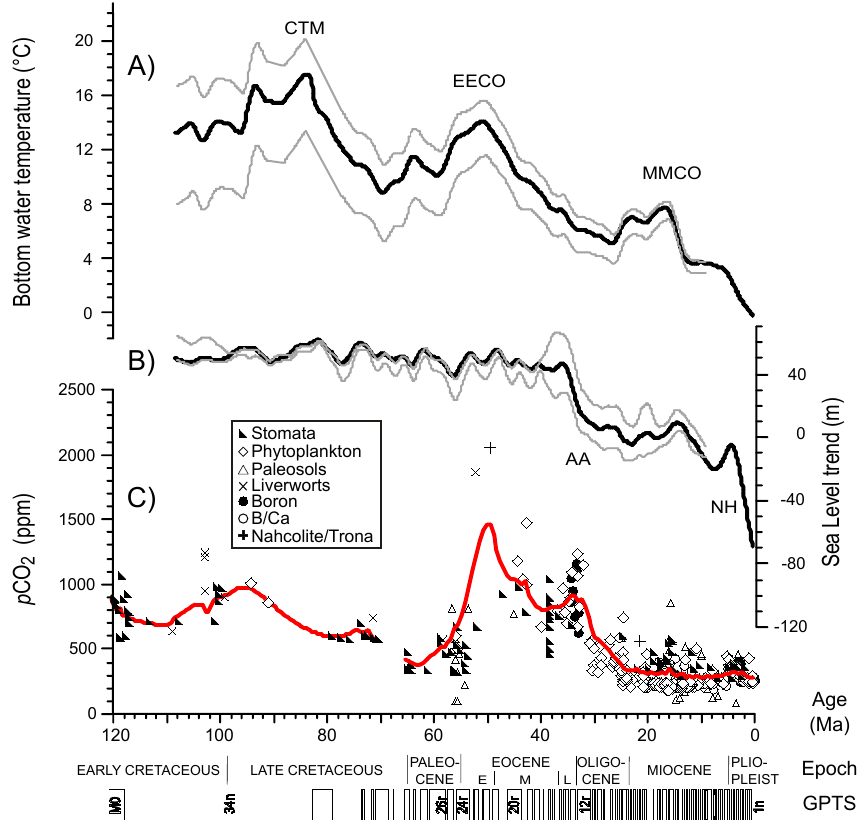
Fig. 1. Bottom water temperatures (A) and reconstructed sea levels (B) since the Early Cretaceous (Cramer et al., 2011) smoothed to emphasize variations on > 5Myr timescales. CTM is Cretaceous thermal maximum, EECO is early Eocene climatic optimum, and MMCO is middle Miocene climatic optimum; AA is sea-level drop at the inception of Antarctic ice sheets, and NH is sea-level drop at the inception of Northern Hemisphere ice sheets. (C) Atmospheric p CO 2 estimates from various proxies from compilation of Royer (2010) for pre-70Ma interval (except paleosol estimates, which are highly scattered and have not been plotted) and of Beerling and Royer (2011) for post-70Ma interval. Simple smoothing functions have been fit (heavy curved line) through the mean p CO 2 estimates provided in the compilations. Ages and epochs registered to GPTS (geomagnetic polarity time scale) of Cande and Kent